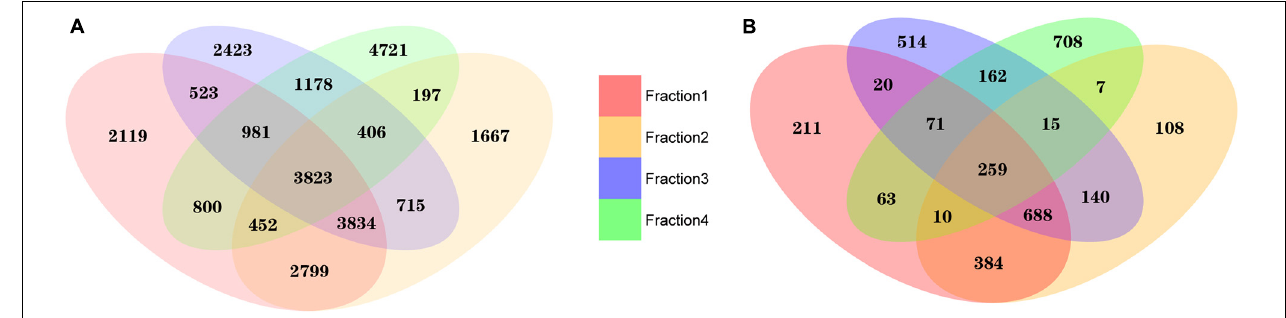
FIGURE 3 | Unique and overlapping transcripts in four plasma fractions. (A) Average read count of transcripts ≥ 1 in each fraction. (B) Average read count of transcripts ≥ 10 in each fraction. The numbers 1–4 represent fractions for Precipitate 1, Precipitate 2, EV Precipitate, and the leftover, respectively.